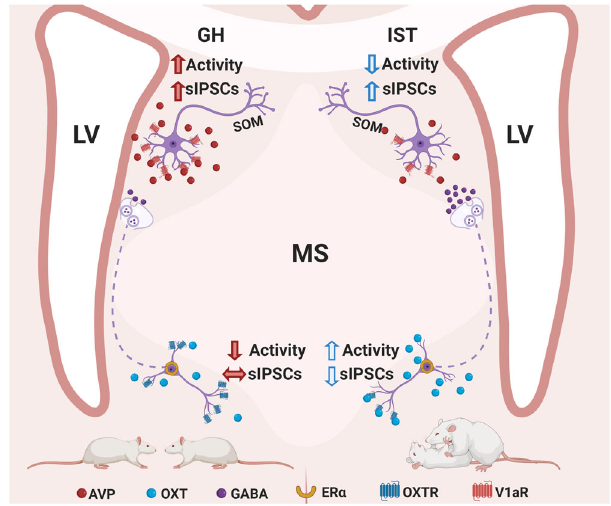
Fig. 8 The balance between OXT and AVP regulates the inhibitory tonus within the LS in order to control aggression in female rats. The scheme depicts the main fi ndings of this manuscript. Furthermore, it hypothesizes that subtle alterations in OXT and AVP release within the LS may impact GABAergic neurotransmission to generate aggressive behavior in female rats. On the left side is depicted, how the brain of a GH female responds to an intruder: a combination of low OXT release ventrally and high AVP release dorsally evokes an increased activity of the dLS, thereby reducing aggression. On the right side is depicted, how the brain of an IST female responds to an intruder: a combination of high OXT release ventrally and low AVP release dorsally culminates in increased tonic inhibition of dLS (dotted line indicates hypothetical pathway) and increased activation of the vLS, promoting aggression. Dorsal and ventral neurons are shown in proportion to their real size. AVP arginine vasopressin, ER α estrogen receptor α , IPSC inhibitory post-synaptic current, LV lateral ventricle, MS medial septum, OXT oxytocin, OXTR oxytocin receptor, SOM somatostatin, V1aR V1a receptor. Drawn using